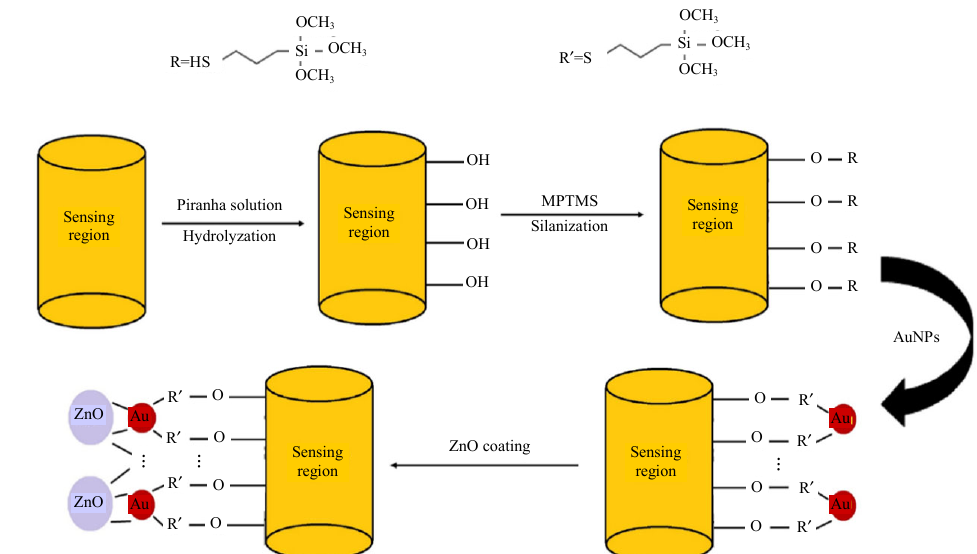
Fig. 2 Immobilization of nanoparticles over the sensing region of fiber probes.